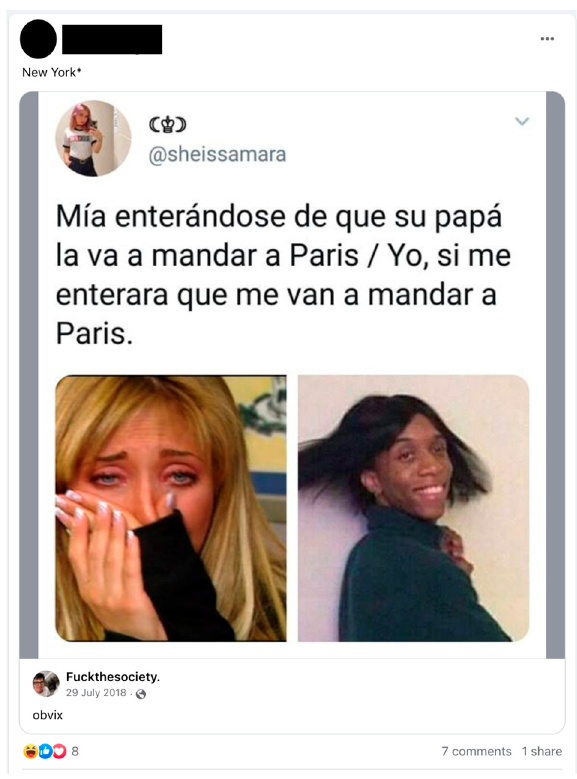
Figure 1. If I were sent to New York. (meme). The meme features, on the left, Mia, a character from a popular Mexican telenovela, in tears, whereas on the right we can see a joyful, happy person. The accompanying text states: “Mia finding out that her father is going to send her to Paris/Me, if I would find out that I would be sent to Paris”. Maria, the participant, added “New York” in her post because she would like to go to New York instead of Paris. This is an example of how her reaction would be if she would be Mia.